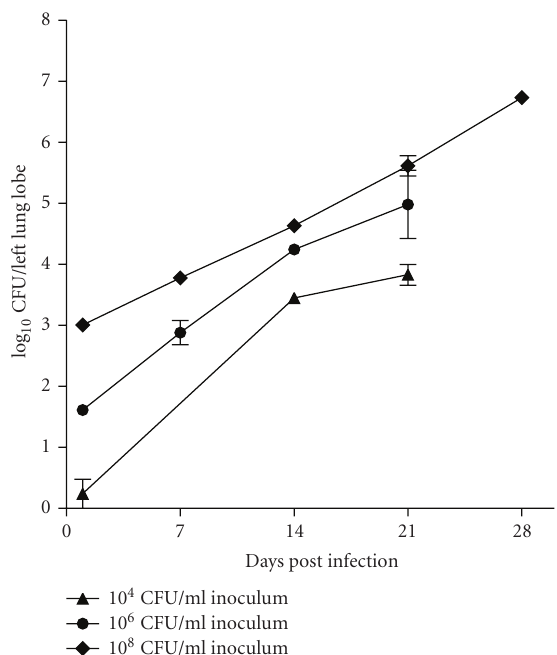
Figure 1: Standardisation of M. tuberculosis aerosol infection in Wistar rats: initial bacillary load and course of infection observed over a period of 4 weeks, following challenge with three di ff erent infection inocula.